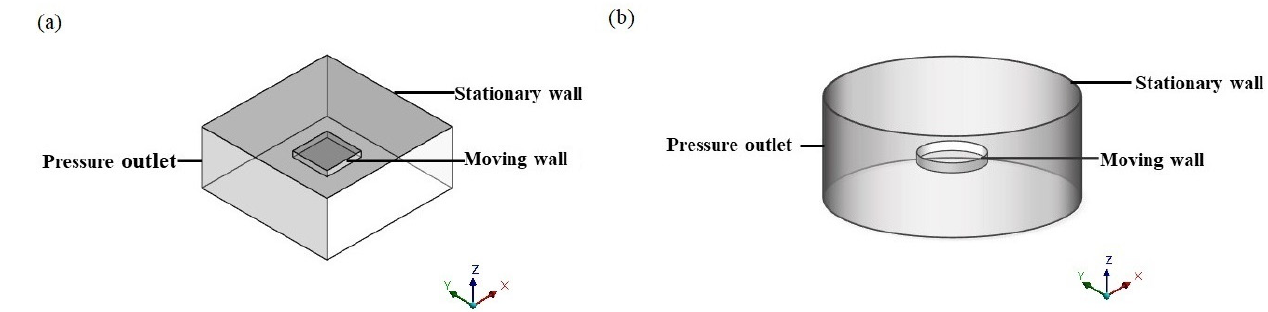
Figure 3. The compact simulation geometries for the ( a ) rectangular plate and ( b ) circular plate.